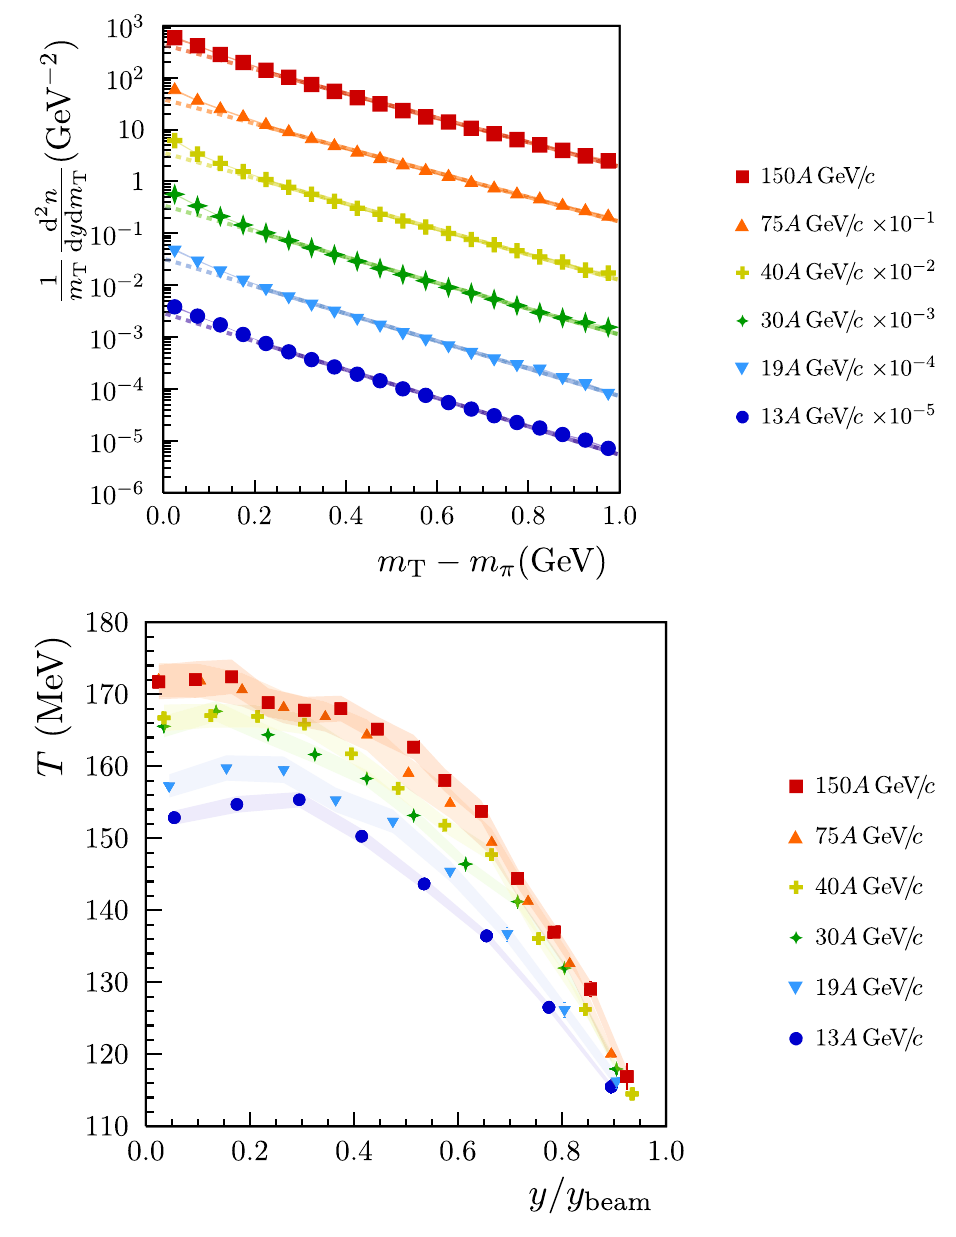
Fig. 11 Transverse mass spectra at mid-rapidity (0 < y < 0 . 2). The fitted exponential function is indicated by solid lines in the fit range 0 . 24 < m T − m π < 0 . 72 GeV and dashed lines outside the fit range. The data points for different beam momenta were scaled for better readability. Statistical uncertainties are smaller than the marker size. Systematic uncertainties are not plotted